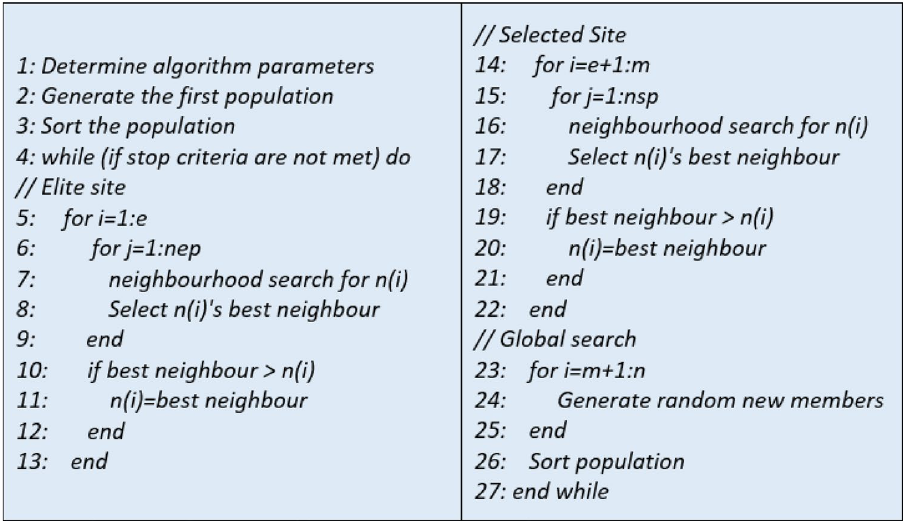
Figure 3. Pseudo-code of BA.